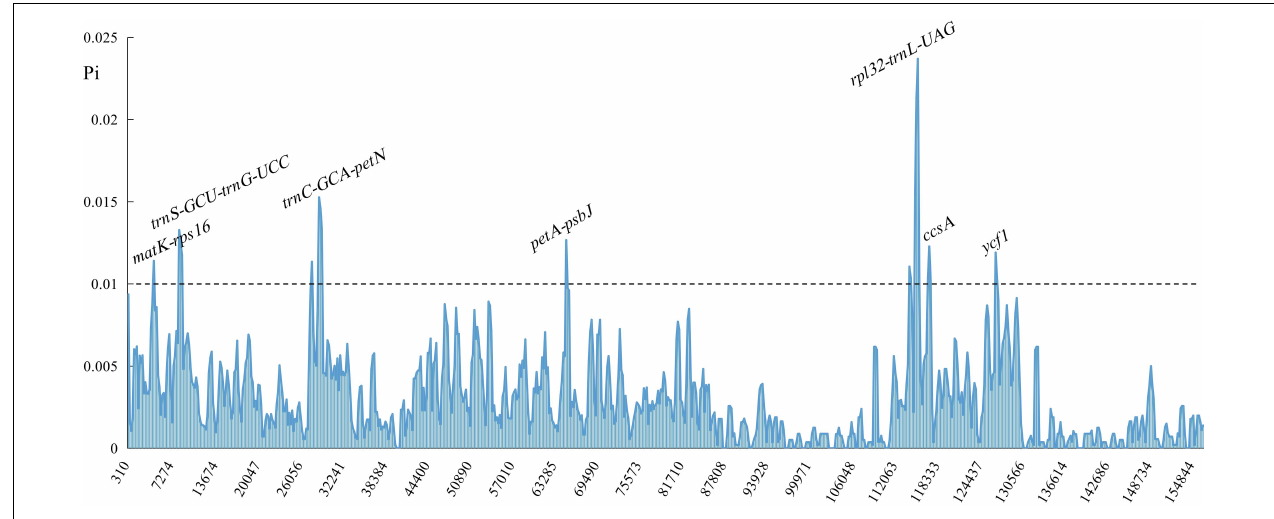
FIGURE 3 | Sliding window analysis of Polygonatum cp genome. The X-axis represents the midpoint of the window; the Y-axis represents nucleotide diversity values.